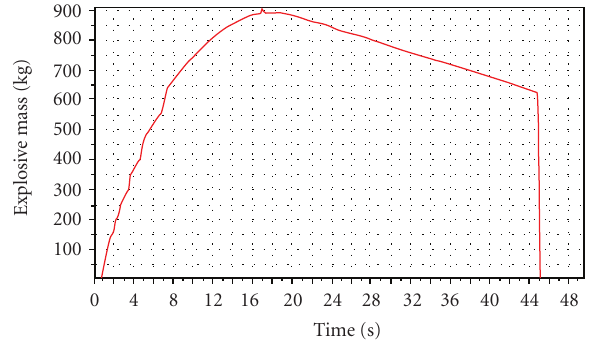
Figure 8: Explosive mass D1538.